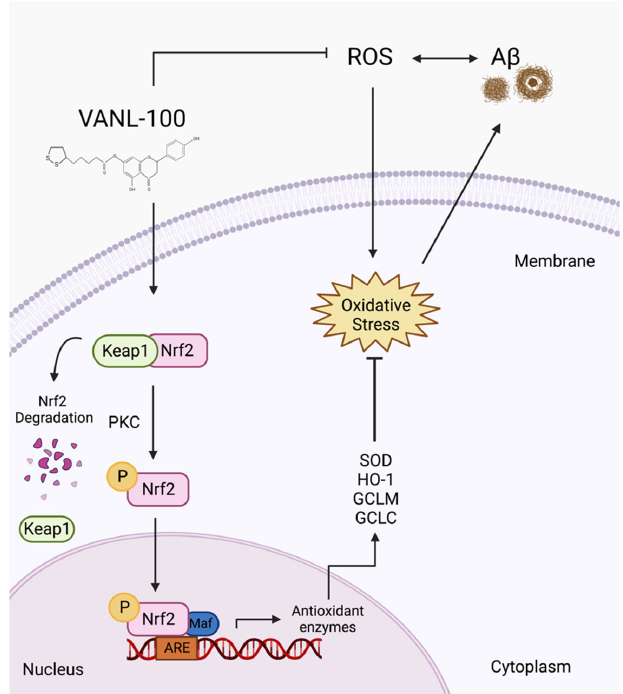
Figure 9. Schematic of the proposed mechanism of action of VANL-100. VANL-100 may act as an Nrf2 activator to stimulate the production of antioxidant and detoxifying enzymes that inhibit oxi- dative stress and its contribution to the production and accumulation of A β . Created using BioRen- der.com.